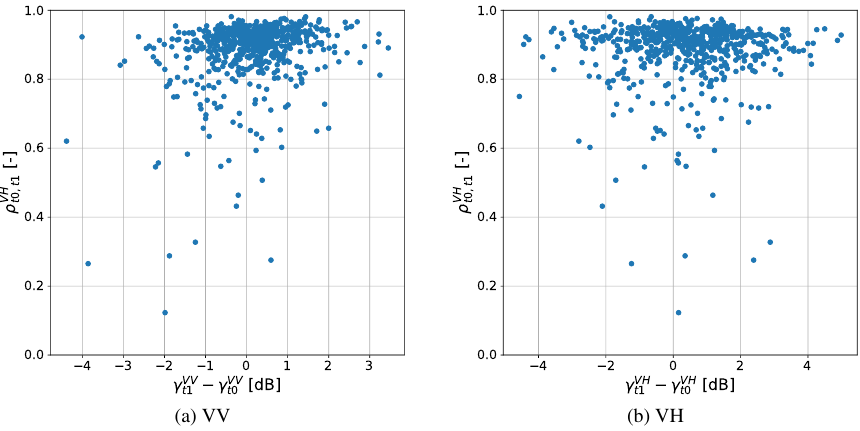
Figure 8. Relation between difference of intensity of the two polarizations 8a) VV and 8b) VH and interferometric SAR coherence of the VH polarization ρ 0 in between the dates of 11/04/2020 and 23/04/2020 for all the pixel of the field 3 of La Cruz de Elias.